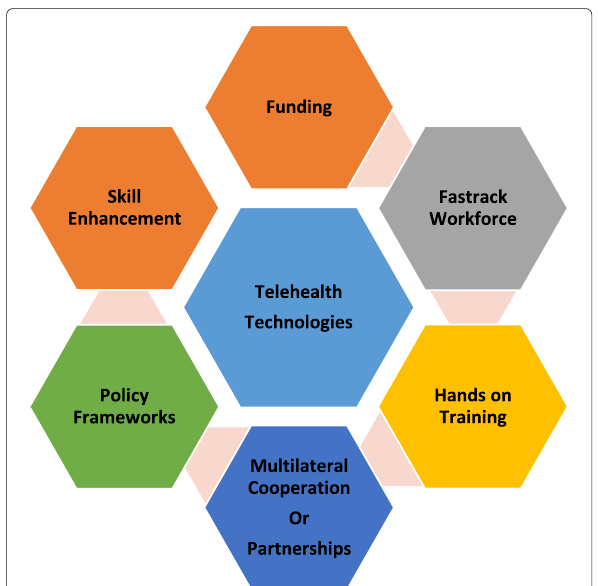
Fig. 1 A Roadmap to the success of Telehealth